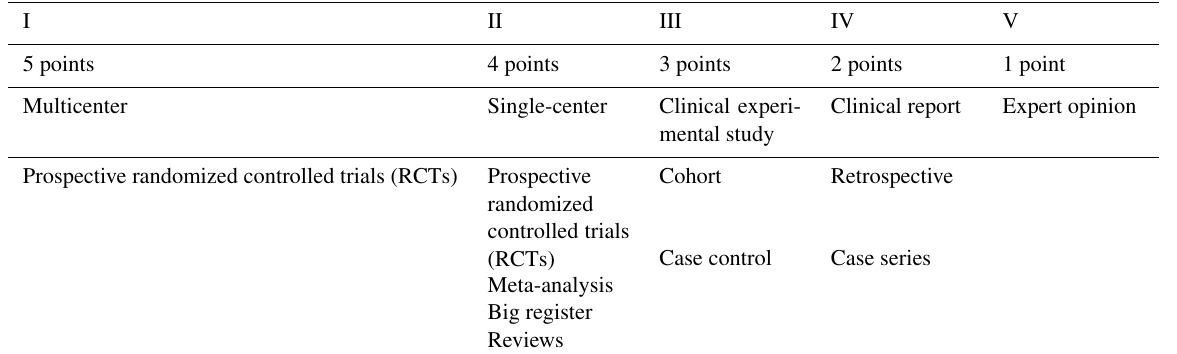
Table 1. Study level.